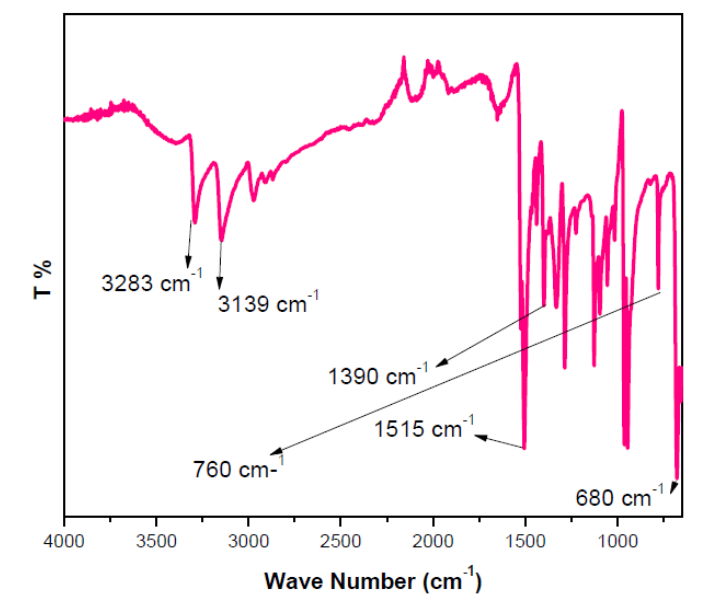
Figure 3. FTIR spectrum of mancozeb